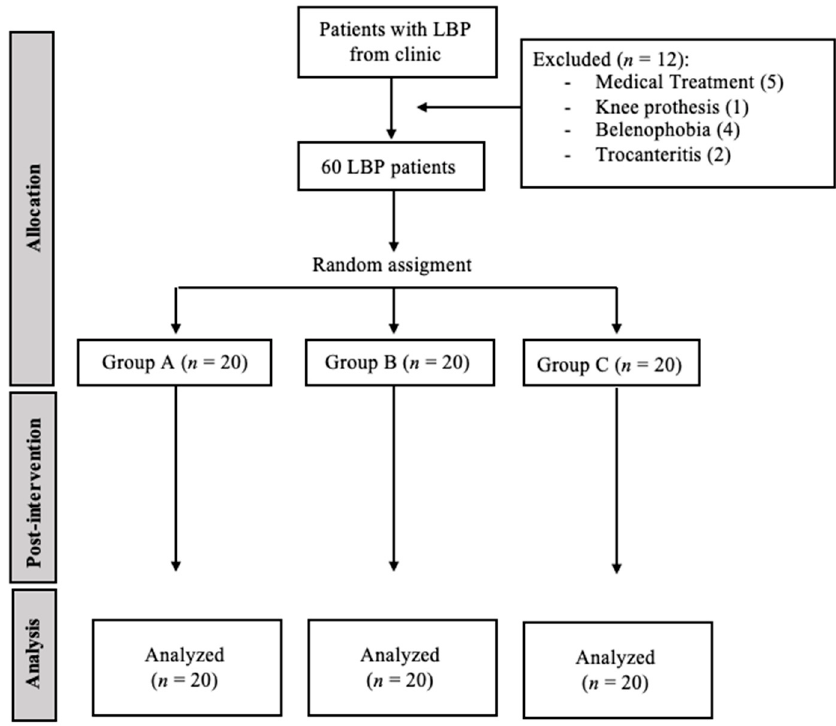
Figure 1. Provides a flowchart of subject recruitment during the study.